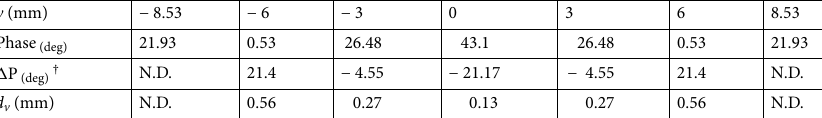
Table 1. Modulation procedure of the proposed lens. † (cid:31) P = (phase value at edges y = ± 8.53 ) − (phase at the sampling